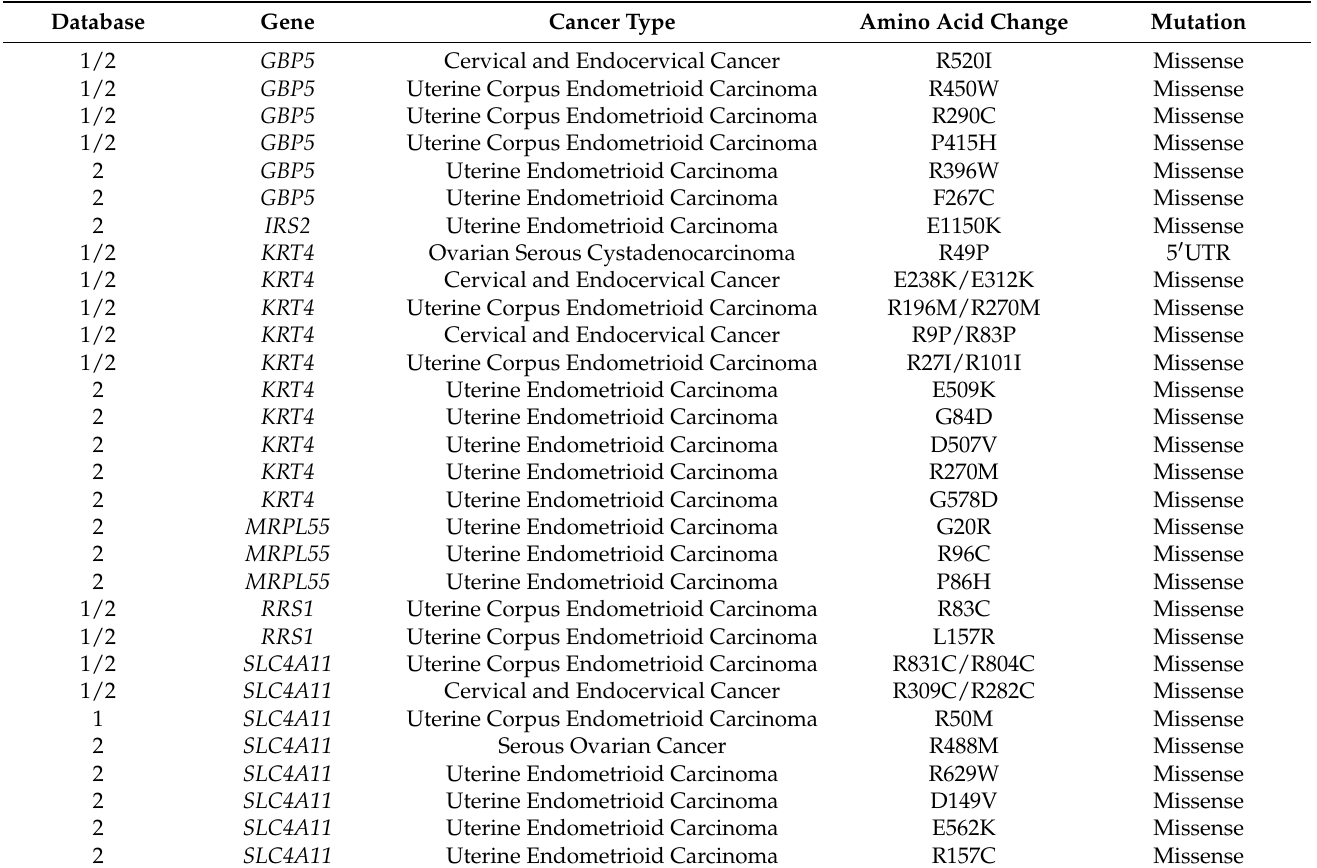
Table 3. Data summary of the gynaecological cancer amino acid changes, where n = 30, showing opposite polarity, charges and water affinity. 1—USCS Xena and